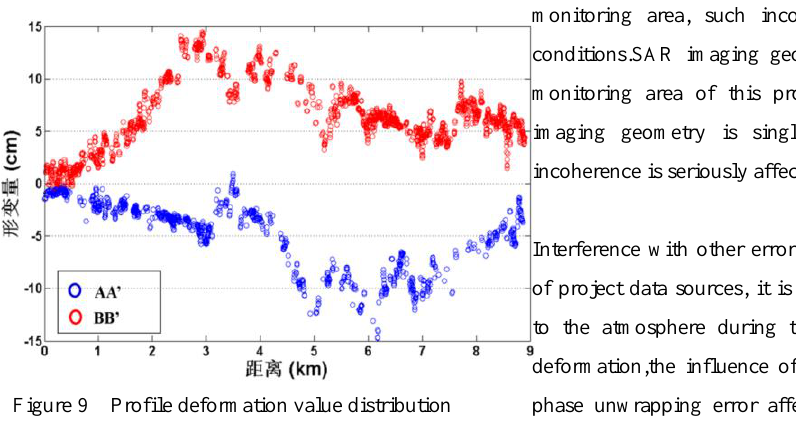
Figure 9 Profile deformation value distribution